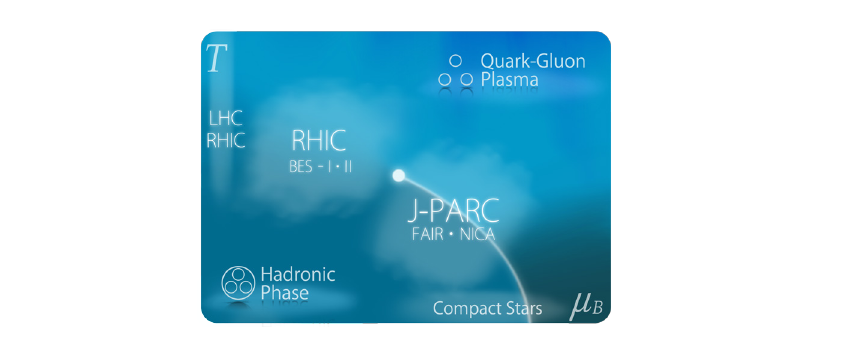
Figure 1. Conceptual phase diagram of QCD on the T – µ B plane